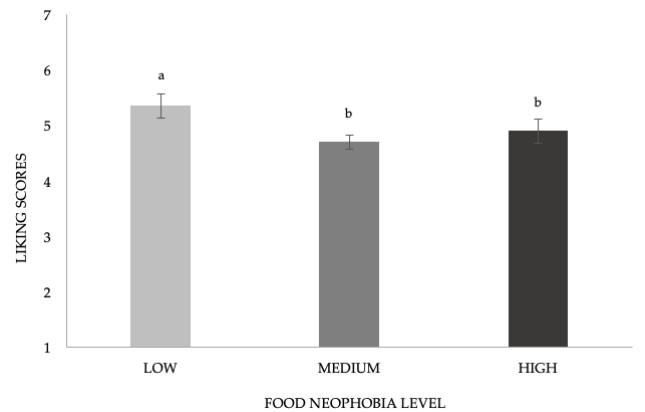
Figure 2. Mean liking scores ± SEM according to food neophobia levels. Different letters indicate significant differences according to post hoc test.